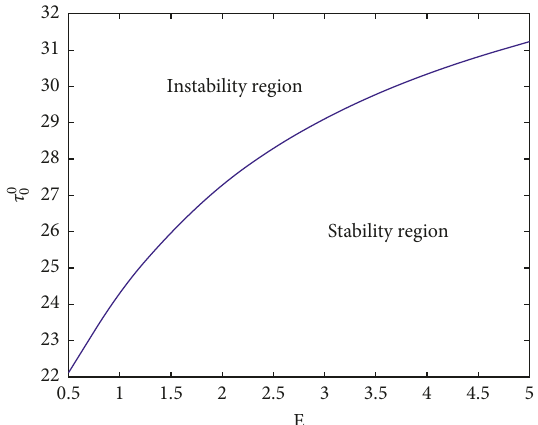
Figure 13: Stability region exploring the dynamics of system (9) in (E, τ 0